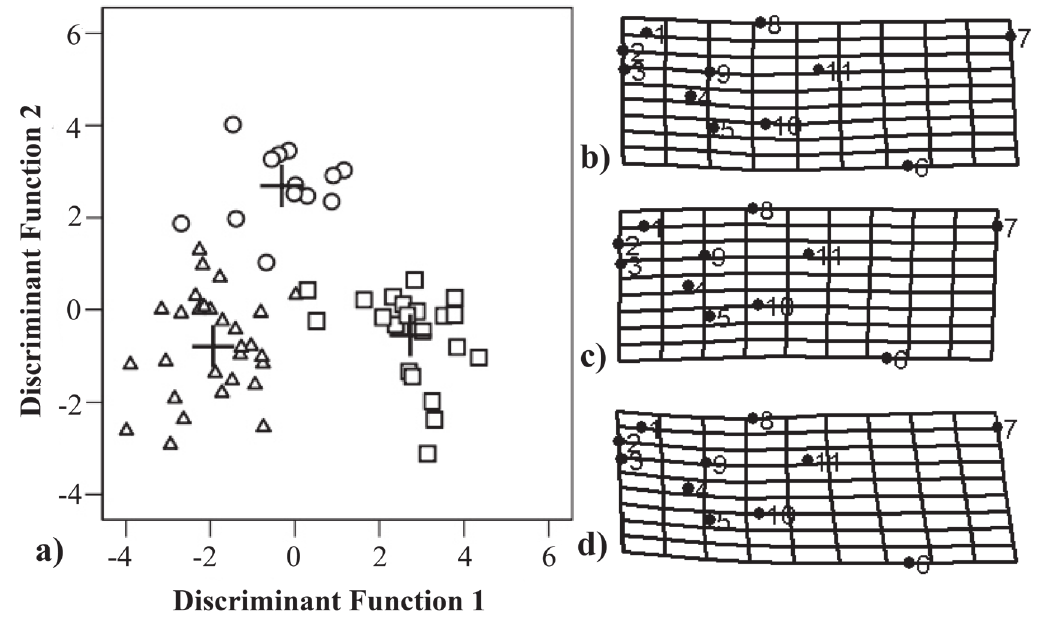
Fig. 7. a ) Discriminant function 1 versus discriminant function 2 for head shape of juvenile individuals fed with different food types; zooplankton (circles), Tubifex sp. (triangles), and just captured individuals (squares). Crosses indicate group centroids. Deformation grids correspond to ( b ) individuals fed with zooplankton and ( c ) Tubifex sp., and d ) just captured individuals.